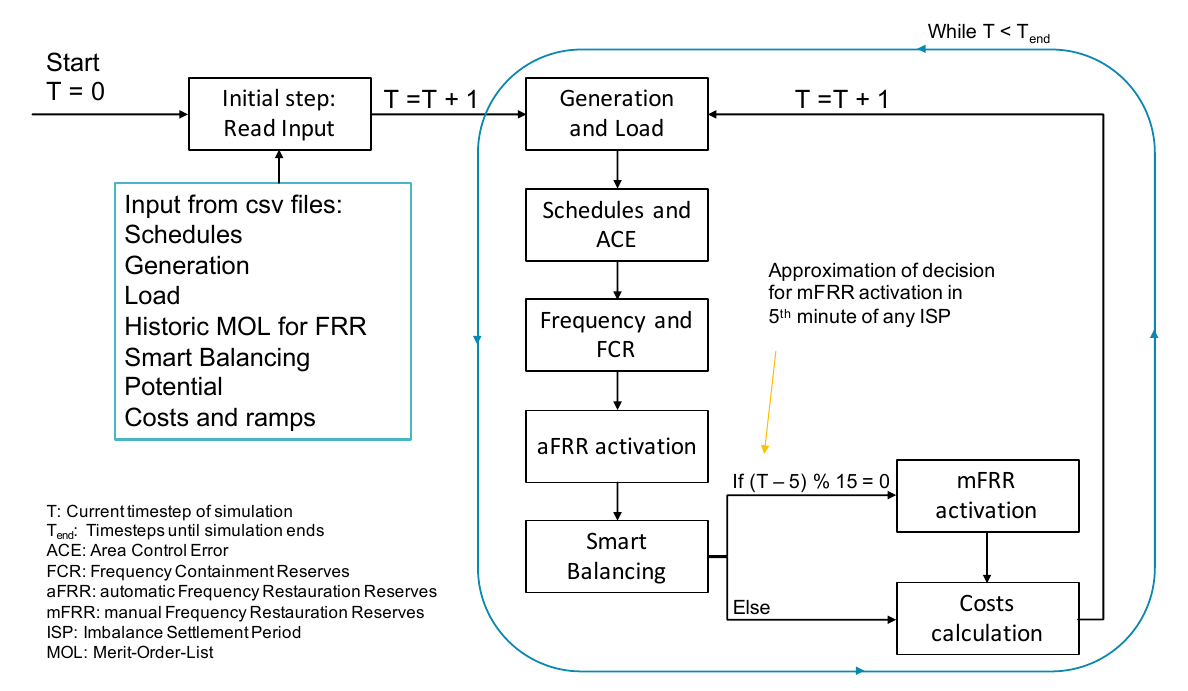
Figure 2. Flowchart of smart balancing simulation.